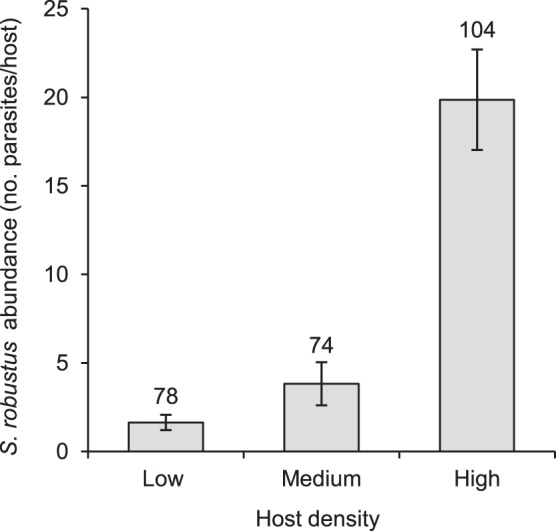
Variation of S. robustus abundance by host density.Mean abundance of S. robustus (sample size above standard error bars) varied with density of hosts in the site (p<0.0001). Squirrels living in high-density sites were more infested than individuals living in medium- and low-density sites (both sequential Bonferroni adjusted p<0.0001) and squirrels living in medium-density sites were more infested than in low-density sites (adjusted p = 0.0008).